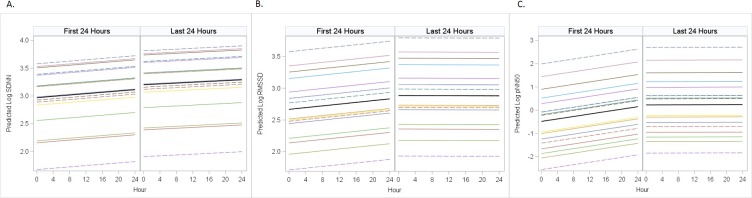
Mixed effects model demonstrating predicted average log heart rate variability in the first vs. last 24 hours of PICU stay.The predicted log HRV is demonstrated for each patient (colored lines) as well as the average value (solid black line) in the first 24 hours of PICU admission (left panel) vs. last 24 hours (right panel). Each colored line indicates an individual patient’s conditional predicted HRV accounting for random effects with the solid black line representing the marginal predicted mean accounting only for fixed effects. Hour represents the number of hours that have passed after admission (left panel) or number of hours that have passed in the 24 hours prior to discharge (right panel). Hour 0 in the first period is the first measurement upon admission; hour 0 in last period is 24 hours before discharge. Mixed models demonstrated that all three measures of HRV were significantly lower during the first 24 hours compared to the last 24 hours of PICU admission (p<0.001).